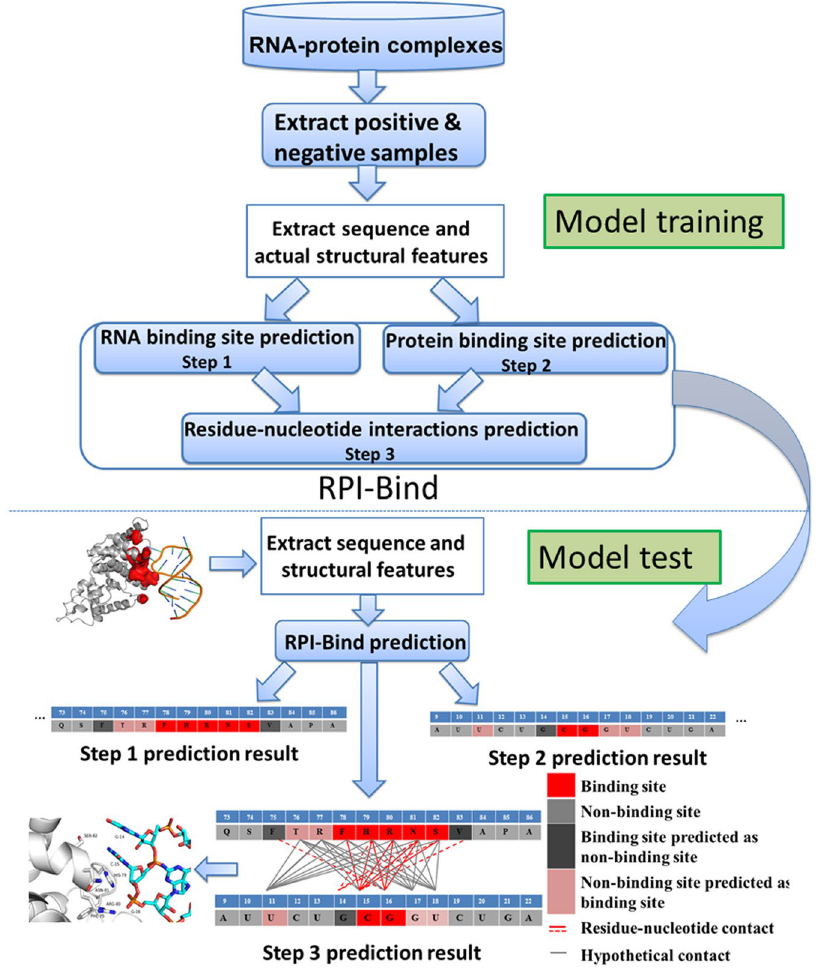
Figure 1. The step-wise work flow of the RPI-Bind prediction method. The whole work flow consists of two steps: training classification models and the applications. The model training process includes various processes, such as construction of the training dataset, feature extraction from sequences and structures in the training data set and development of ‘RPI-Bind’ method, consisting of three models. The developed models were then applied to solve three problems, including 1) the prediction of RNA binding regions on protein, 2) the prediction of protein binding regions on RNA, and 3) the prediction of interacting regions onboth RNA and protein